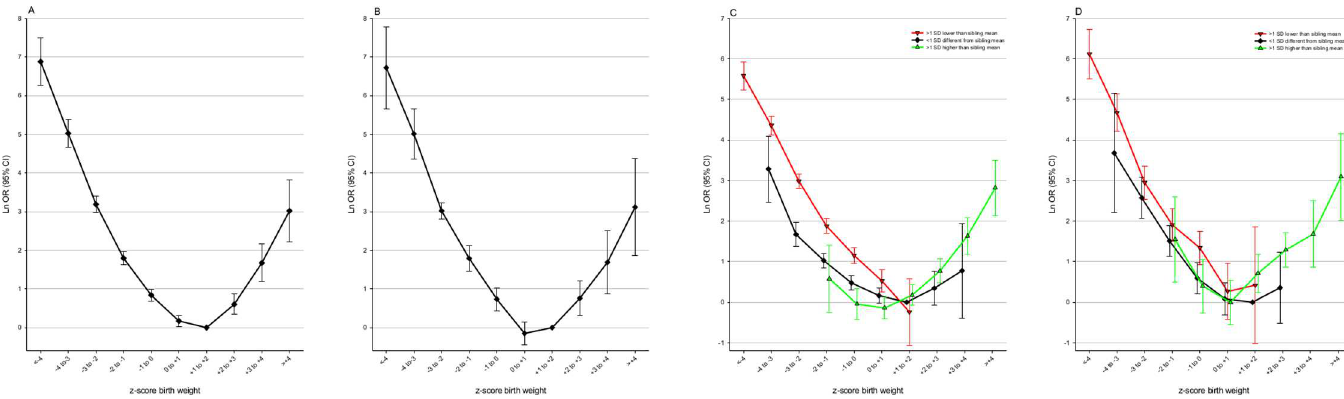
Fig 6. Sensitivity analysiscomparing associations between perinatal death and zBW in first-born and last-born infants. CI: confidenceinterval;OR: oddsratio; SD: standarddeviation;zBW: z-scorebirth weight,standardized for year of birth, sex, birth order,gestational week,andplurality. (A) First-born infants. The modelincludes potentialconfounders in Model2 (B) Last-born infants. The modelincludespotentialconfounders in Model2 (C) First-born infants.The model includesvariablesas in Model2, with the exception that a 30-category interactionterm is substitutedfor zBW andmeansibshipzBW. Reference:participant zBW +1 to +2 and < 1SDdifferentfrom meansiblingzBW (D) Last-borninfantsThe modelincludesvariablesas in Model2, with the exceptionthat a 30-category interactionterm is substitutedfor zBW andmeansibshipzBW. Reference: participant zBW +1 to +2 and < 1SDdifferentfrom meansiblingzBW. See Table 1 foot- note for